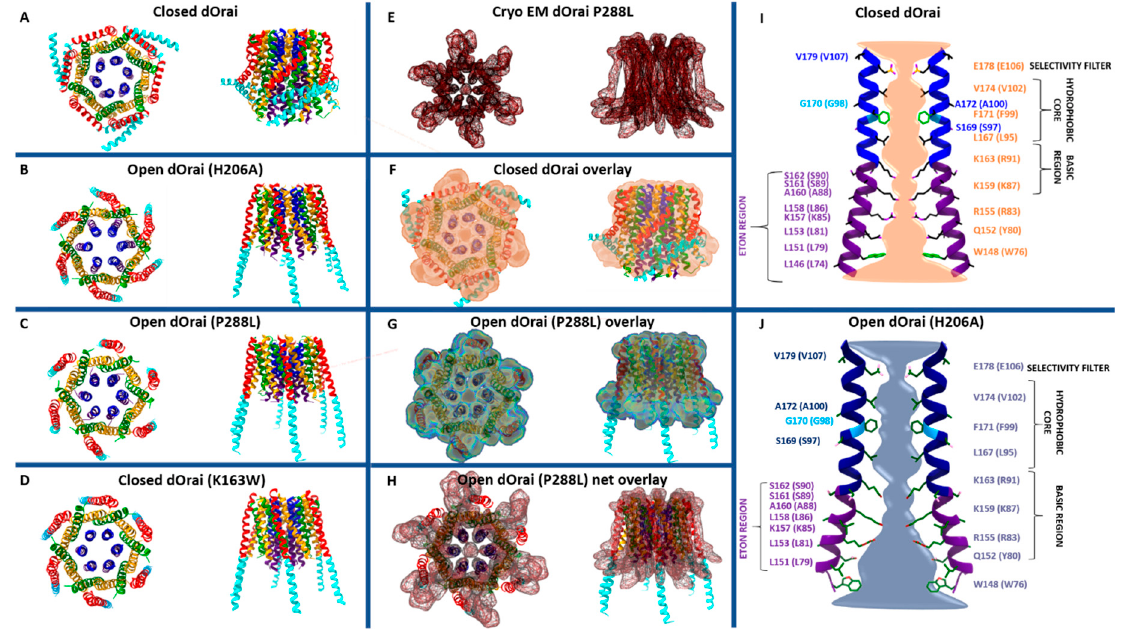
Figure 2. Structure of Orai channel. (A–D) Top and the corresponding side view of the crystal structure of the closed dOrai ( A ), the open state of dOrai H206A (analogue to Orai1 H134A) ( B ), the open state of dOrai P288L (analogue to Orai1P245L) ( C ), and the closed state of dOrai K163W (analogue to Orai1 R91W) ( D ) are shown. ( E ) Top and the corresponding side view of the net cryo-EM (cryogenic electron microscopy) structure of the open state of dOrai P288L (analogue to Orai1P245L). ( F , G ) Overlay of cryo EM dOrai P288L structure with the closed dOrai and open dOrai P288L crystal structures. ( H ) Overlay of net cryo EM dOrai P288L structure with open dOrai P288L crystal structure. ( I , J ) The pore of the closed dOrai channel and open dOrai H206A are displayed (in brackets, the corresponding position in Orai1 is stated). The Ca 2+ - accumulating region (CAR) region, selectivity filter, hydrophobic core, basic region, and extended transmembrane Orai1 N-terminal (ETON) region are visualized by their respective